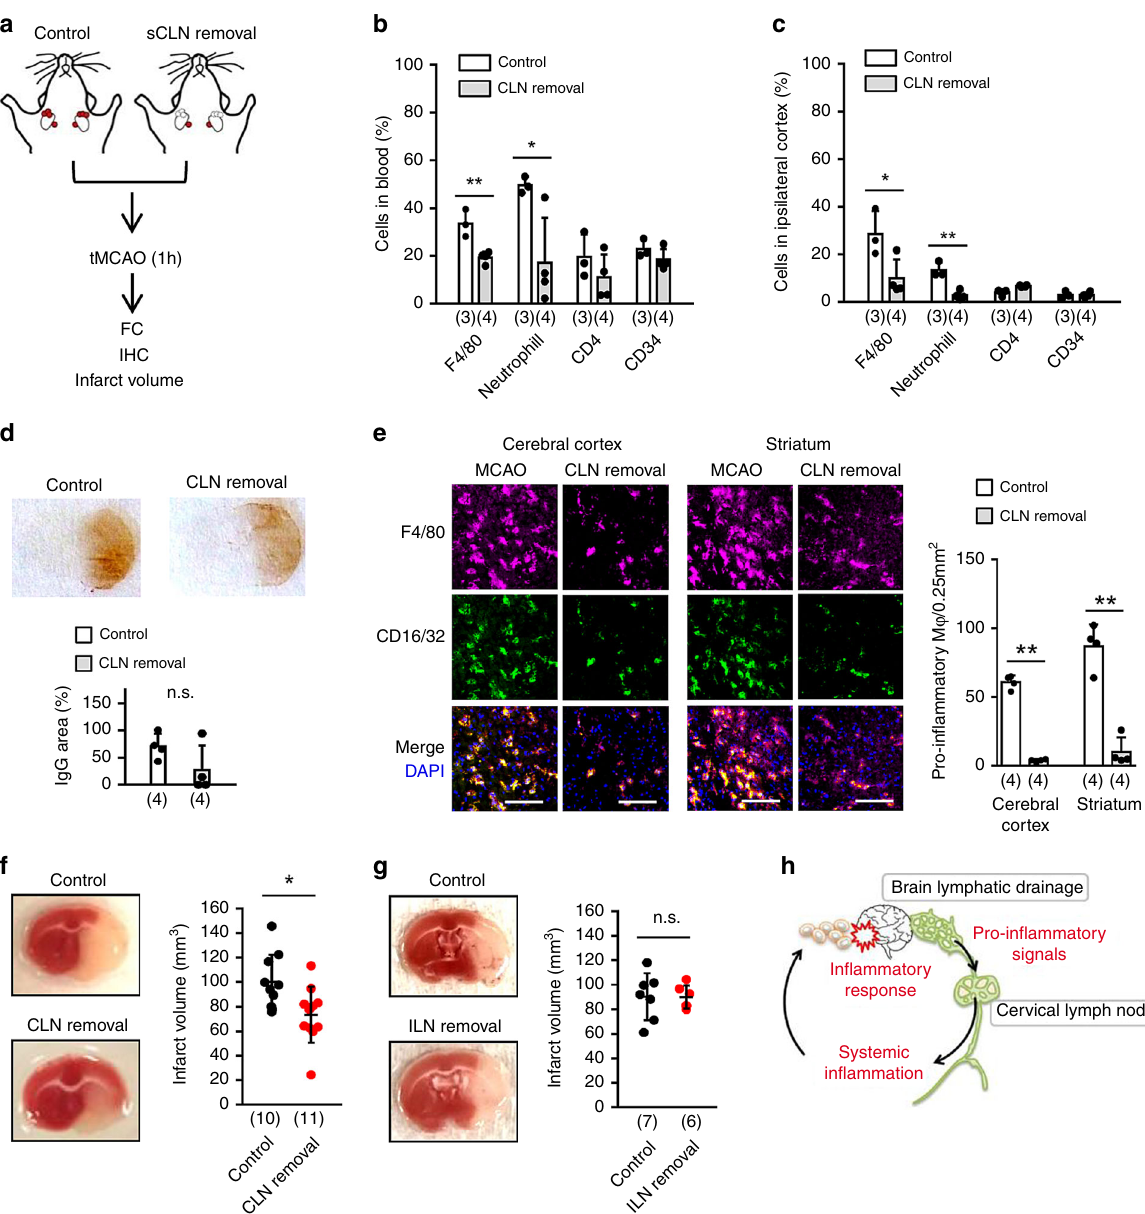
Fig. 7 Super fi cial cervical node lymphadenectomy reduces brain damage after stroke: a Super fi cial CLNs were surgically removed from C57BL6 mice, then mice were subjected to transient 60 min focal cerebral ischemia. b , c Flow cytometry analysis demonstrated that accumulations of neutrophils and F4/80 positive monocytes/macrophages in both systemic circulation ( b ) and injured brain ( c ) were signi fi cantly reduced by super fi cial CLN removal (Control; n = 3, CLN removal; n = 4 biologically independent animals). * P <0.05, ** P < 0.01, one-way ANOVA followed by Fisher ’ s LSD test. d . Percentage of IgG leaked area in the ipsilateral hemisphere was assessed. CLN removal did not signi fi cantly in fl uence IgG leakage after focal ischemia ( n = 4 biologically independent animals). unpaired t -test. e CLN lymphadenectomy signi fi cantly decreased pro-in fl ammatory macrophages in ipsilateral cortex and striatum ( n = 4 biologically independent animals), unpaired t -test. Scale: 100 nm. f CLN lymphadenectomy signi fi cantly reduced infarct volume at 72 h post-stroke (Control; n = 10, CLN removal; n = 11 biologically independent animals). Control: 99.9 + / − 22.3mm 3 , CLN removal: 73.4 + / − 22.7mm 3 . * P < 0.05, unpaired t -test. g Inguinal lymph nodes (ILN) lymphadenectomy did not decrease infarct volume at 72h post-stroke (Control; n = 7, ILN removal; n = 6 biologically independent animals). Control: 90.2 + / − 19.1 mm 3 , ILN removal: 89.9 + / − 9.6mm 3 , unpaired t -test. All values are mean + / − SD. h Schematic of the proposed brain - to-cervical lymph node pathway in the regulation of in fl ammatory response via VEGFR3 signaling after focal cerebral ischemia.